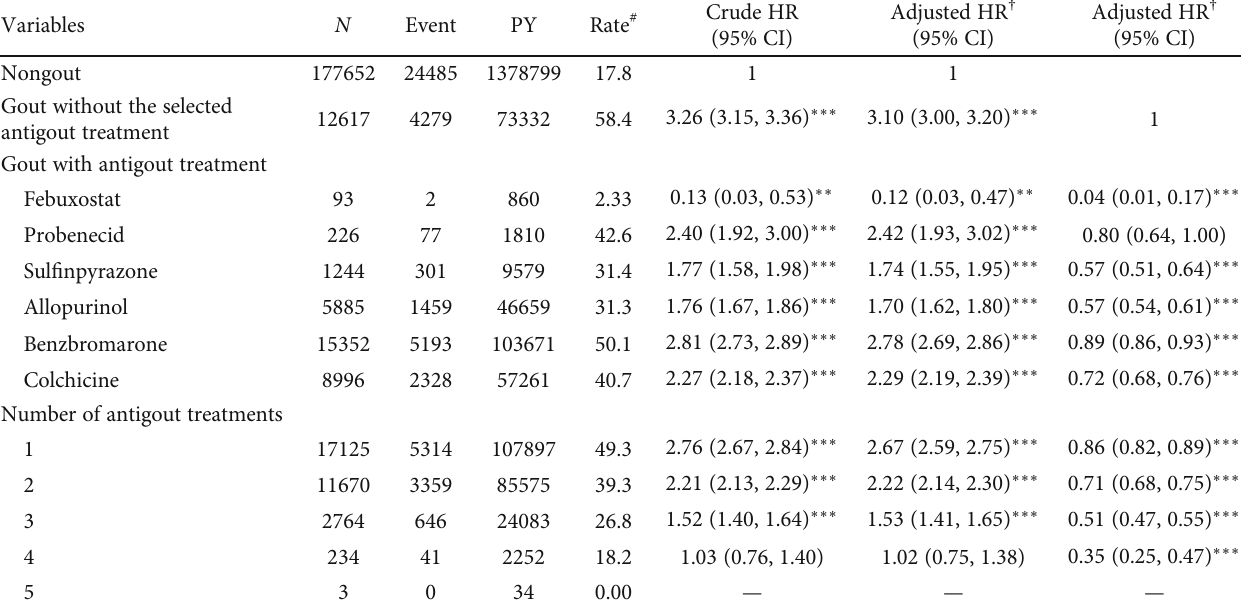
Table 4: Incidence, crude, and adjusted hazard ratio of hyperlipidemia compared among gout patients with or without antigout treatment and compared between gout patients without antigout treatment and nongout